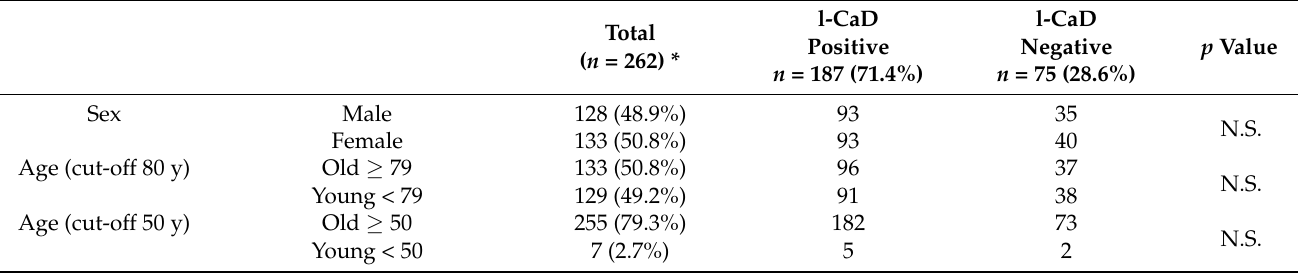
Figure 1. Staining patterns for l-caldesmon (l-CaD; E – H ), and h-caldesmon (h-CaD; I – L ) in colorec- tal adenocarcinoma tissue assessed using immunohistochemical staining together with matching hematoxylin and eosin ( H , E ; A – D ). l-CaD staining ranged from negative/weak ( F , G ) to strong ( H ) cy- toplasmic staining of tumor cells. The stroma was consistently positive for l-CaD. Chromogen, DAB; original magnification 100; scale bar = 200 µ m. Table 1. L-caldesmon expression in colorectal cancer cases and its relationship to clinical and pathological